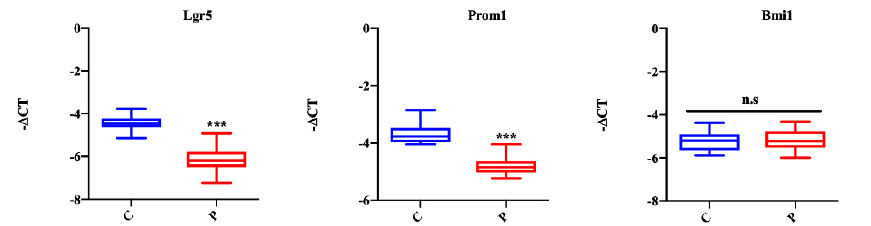
Figure 3. Influence of palmitate treatment on intestinal organoid proliferation. Lgr5, stem cells; Prom1, TA cells; Bmi1, +4 cells. Data generated from three biological replicates from five mice. Unpaired Student’s t test: *** p < 0.001; n.s. not significant. C, control; P, palmitate.